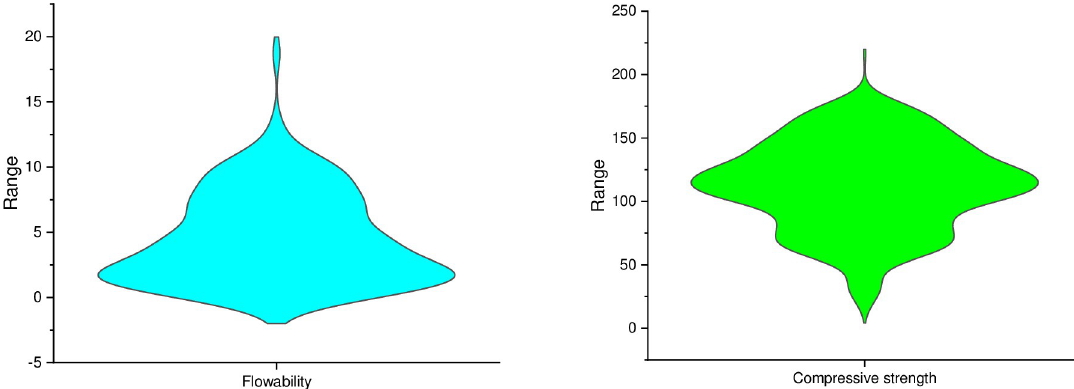
Fig 3. Violin plot for flowability and compressive strength (i.e., output